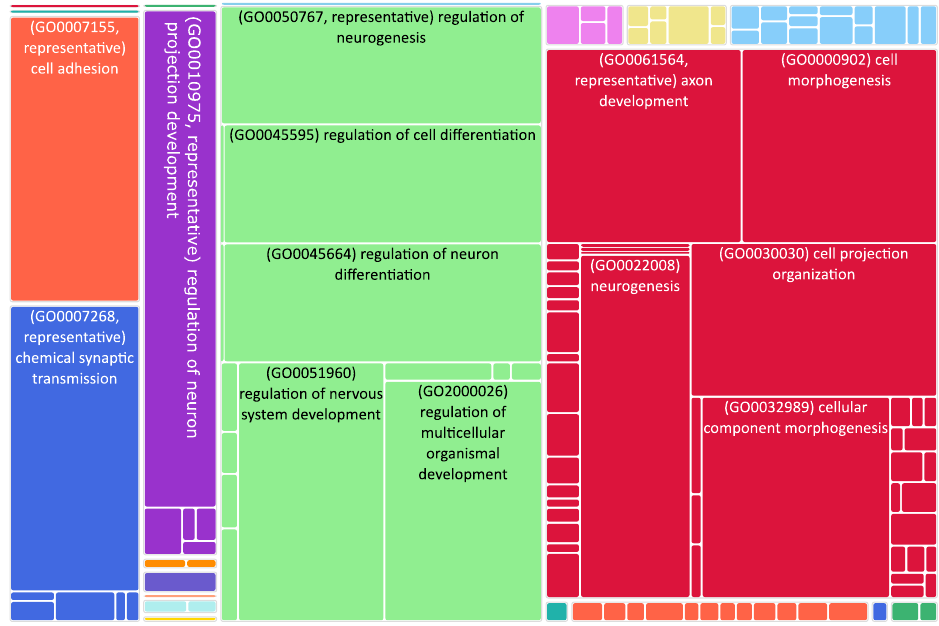
Figure 2. Tree map of downregulated genes in the stage 4 + 4S. Each rectangle is a single cluster representative. The representatives are joined into “superclusters” of loosely related terms, visualized with different colors. Sizes of the rectangles are adjusted to reflect the p -value of the GO term (“biological process”). Most representative terms are indicated. Several terms associated with neuronal function are enriched.